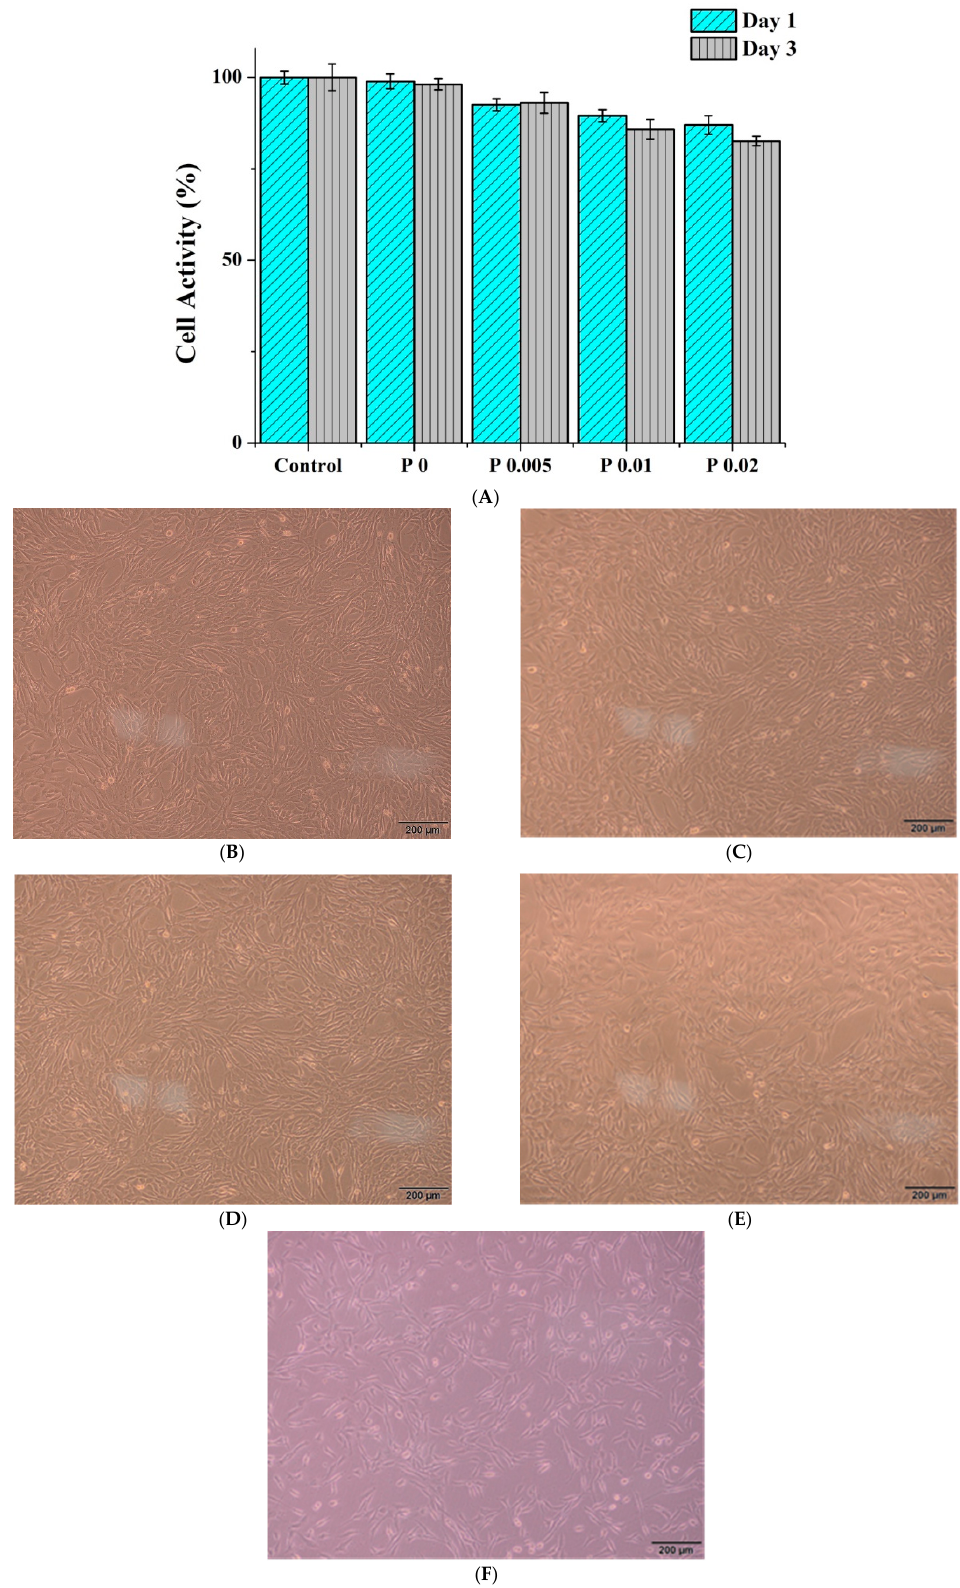
Figure 9. Biocompatibility of nanofiber membranes as related to the P. emblica content: ( A ) MTT cell activity, ( B ) PVP/CS/ P. emblica 0 wt%, ( C ) PVP/CS/ P. emblica 0.005 wt%, ( D ) PVP/CS/ P. emblica 0.01 wt%, ( E ) PVP/CS/ P. emblica 0.02 wt%, and ( B )–( F ) cytocompatibility test on day 3. PVP/CS/ P. emblica nanofiber membranes are tested for their anti-inflammatory ca- pacity. Two inflammatory factors (IL-1 α and TNF- α ) are used for the test. IL-1 α and TNF- α are involved with inflammation and also trigger acute phase reaction proteins. A rise in the inflammatory factors inflicts cells with death, allergy, septicemia, or inflammatory re- actions. As a result, the anti-inflammatory capacity tests with IL-1 α and TNF- α as inflam- matory factors can determine whether nanofiber membranes trigger the inflammation of cells and skins. Figure 10 shows that in the IL-1 α test, the OD for the control group is 0.31 ± 0.01, while the ODs for PVP/CS, PVP/CS/ P. emblica 0.005, PVP/CS/ P. emblica 0.01, and PVP/CS/ P. emblica 0.02 are 0.32 ± 0.02, 0.27 ± 0.01, 0.21 ± 0.01, and 0.18 ± 0.01. Figure 11 shows that in the TNF-1 α test, the OD for the control group is 2.18 ± 0.17 while the ODs for PVP/CS, PVP/CS/ P. emblica 0.005, PVP/CS/ P. emblica 0.01, and PVP/CS/ P. emblica 0.02 are separately 2.54 ± 0.08, 2.00 ± 0.04, 1.81 ± 0.04, and 1.61 ± 0.05. Based on the two anti- inflammatory capacity tests, the incorporation of PVP/CS induces the occurring inflam- matory factors. In contrast, with an increase in the P. emblica content, PVP/CS/ P. emblica groups show a declining trend in the inflammatory factor regardless of whether it is IL- 1 α or TNF- α . Specifically, the PVP/CS/ P. emblica 0.02 demonstrates the optimal inhibition efficacy. It is proved that the nanofiber membranes do not cause an inflammatory reaction and that the incorporation of P. emblica can further reduce the presence of inflammatory factors [46].